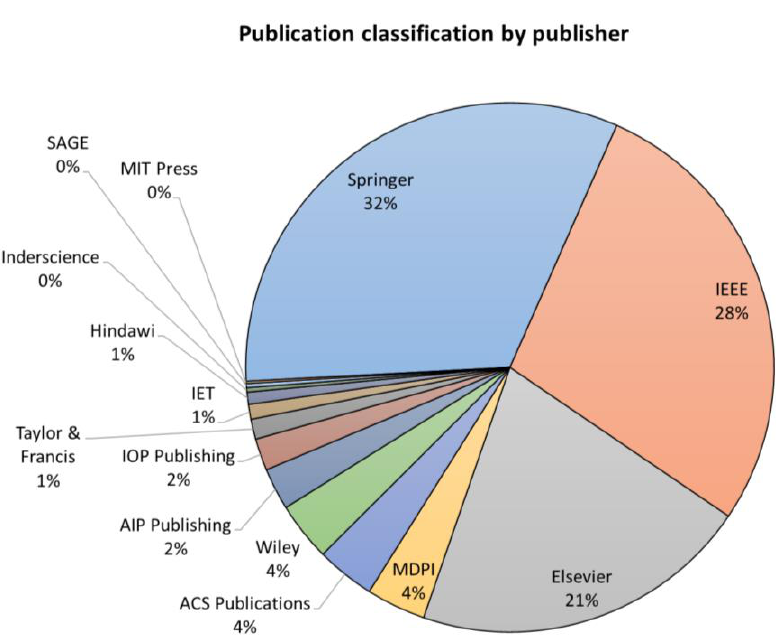
Figure 5. Proportion of publication classification by